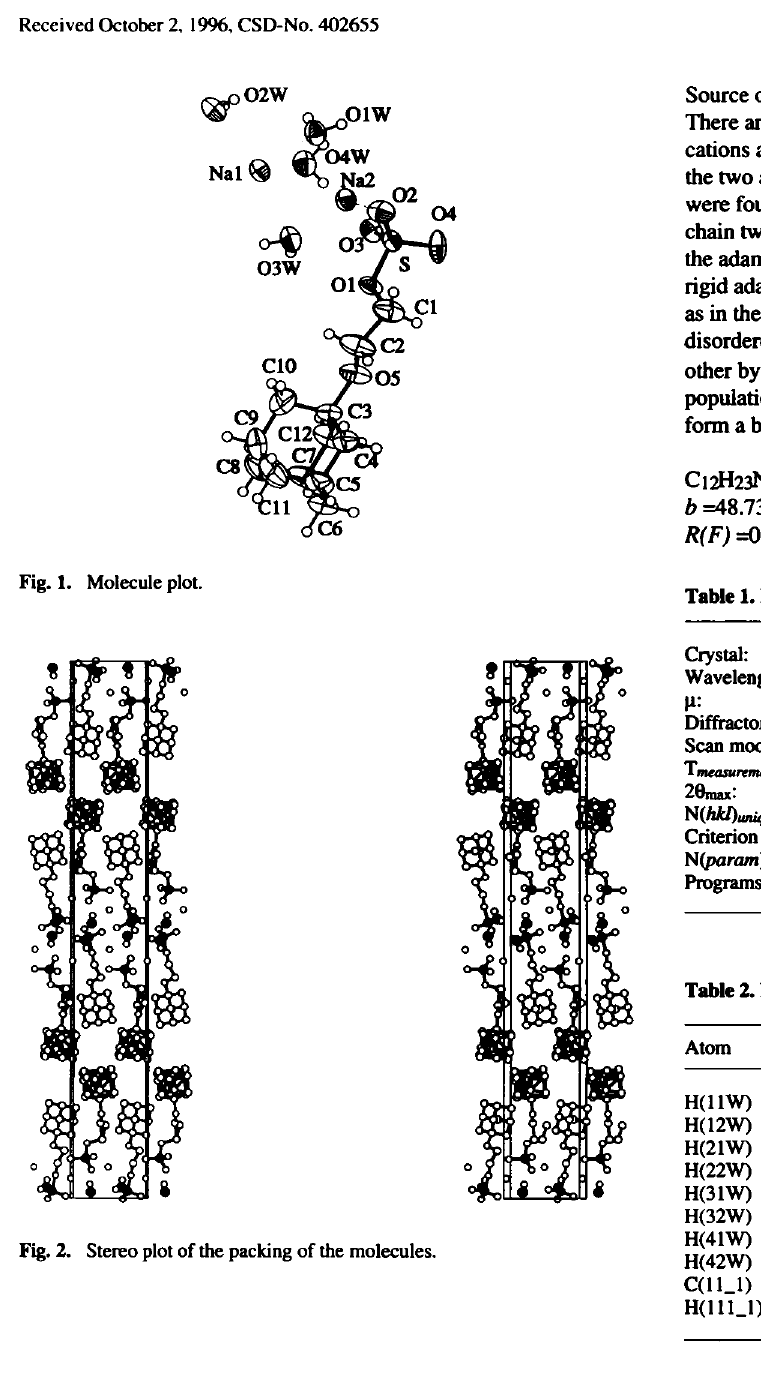
Fig. 1. Molecule plot.